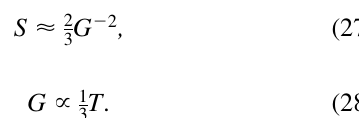
Fig. 2 that the solution of the exact equations and that of the approximate averaged are in a good agreement. Moreover, the integral I is almost constant for the exact equations (1) [see Fig. 2(b)].